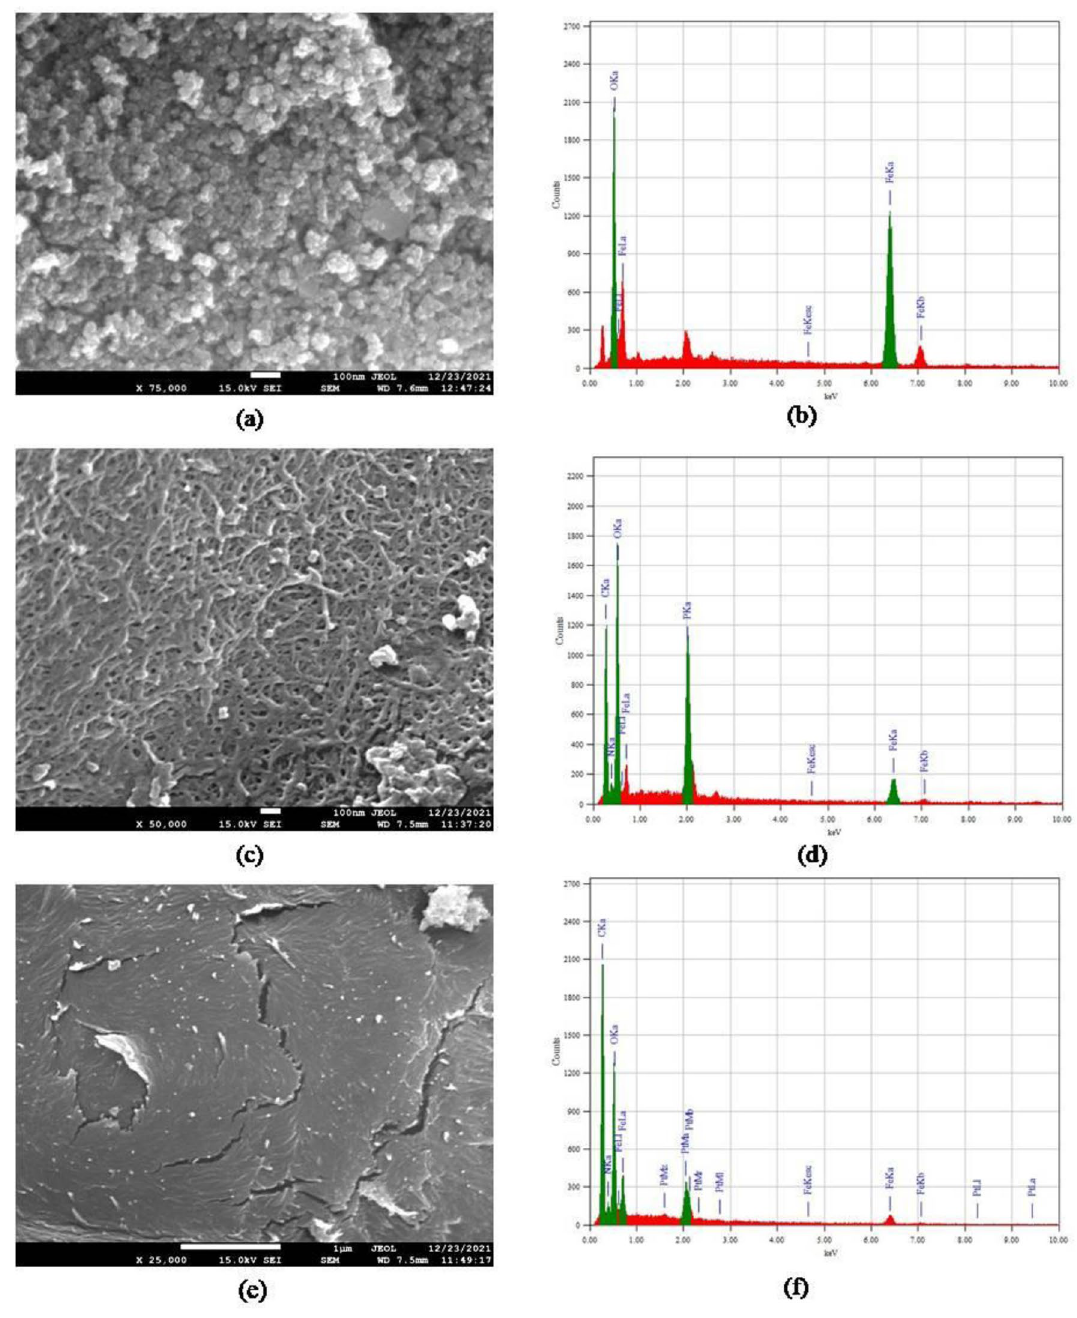
Figure 5. SEM micrographs of ( a ) Fe 3 O 4 nanoparticles, ( c ) TPP-CMN, ( e ) V-CMN and EDX spectra of ( b )